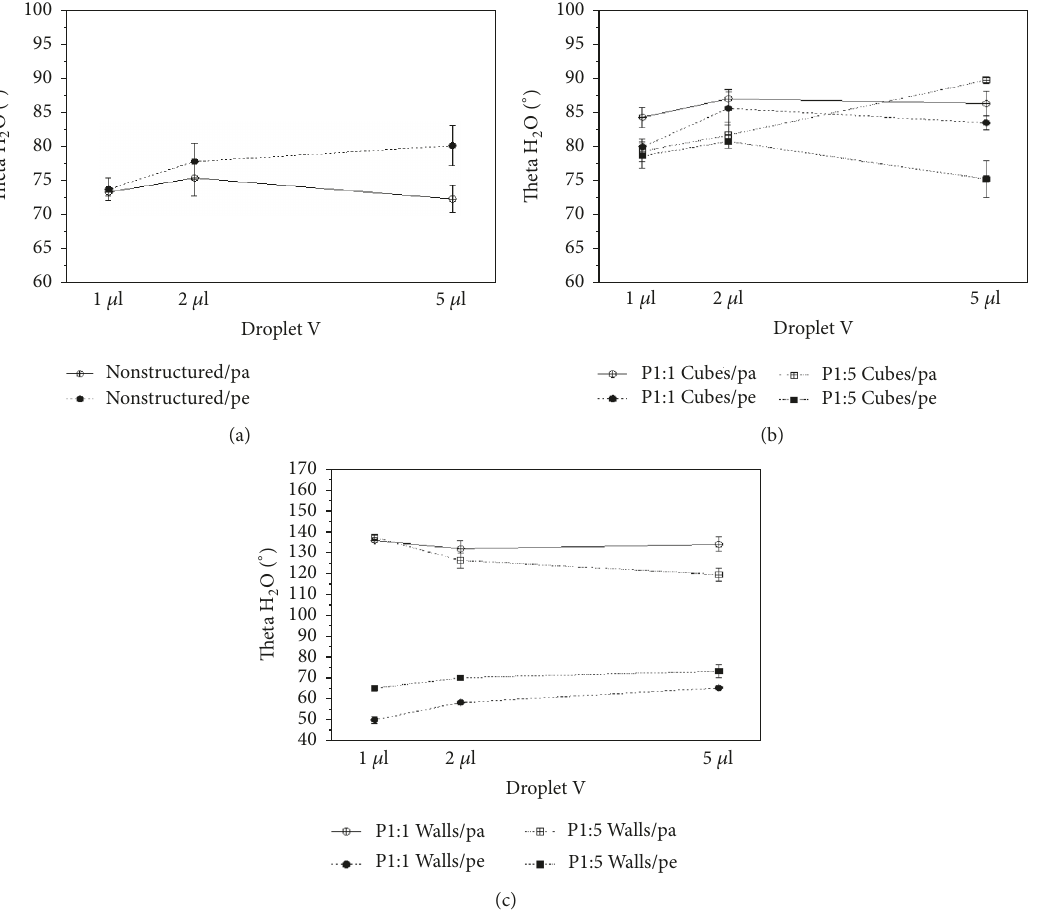
Figure 4: Water contact angles as function of droplet volume and substrate topography. (a) Nonstructured control, (b) cubes, and (c)